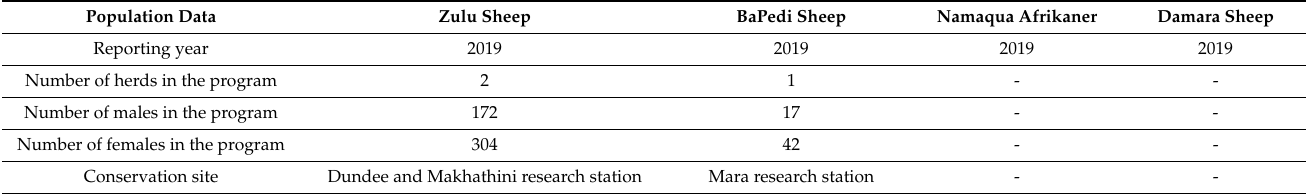
Table 5. In vivo conservation of South African indigenous breeds [16].